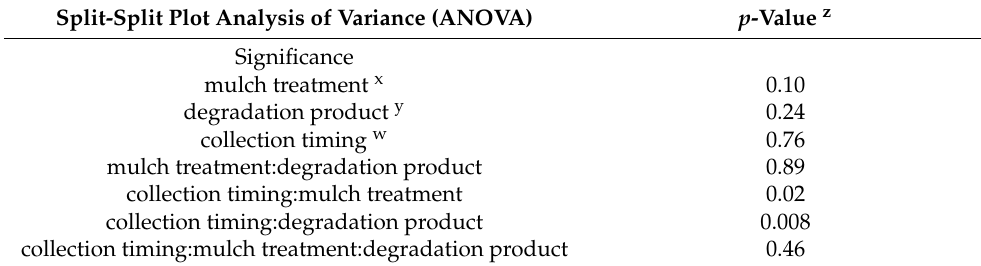
Table 5. Microbial colonization of plastic soil-biodegradable mulch (BDM) surfaces measured before the application of degradation products, and 2-, 7-, and 14-days following product application, using split-split plot analysis of variance (ANOVA). Scanning electron microscopy (SEM) was performed to observe and quantify microbial cells on BDM surfaces before and after product application (compost tea, humic and acetic acids). Plastic mulch samples (BASF 0.6 and Novamont 0.6) were collected in autumn 2019. Split-Split Plot Analysis of Variance (ANOVA) p -Value z Significance mulch treatment x 0.10 degradation product y 0.24 collection timing w 0.76 mulch treatment:degradation product 0.89 collection timing:mulch treatment